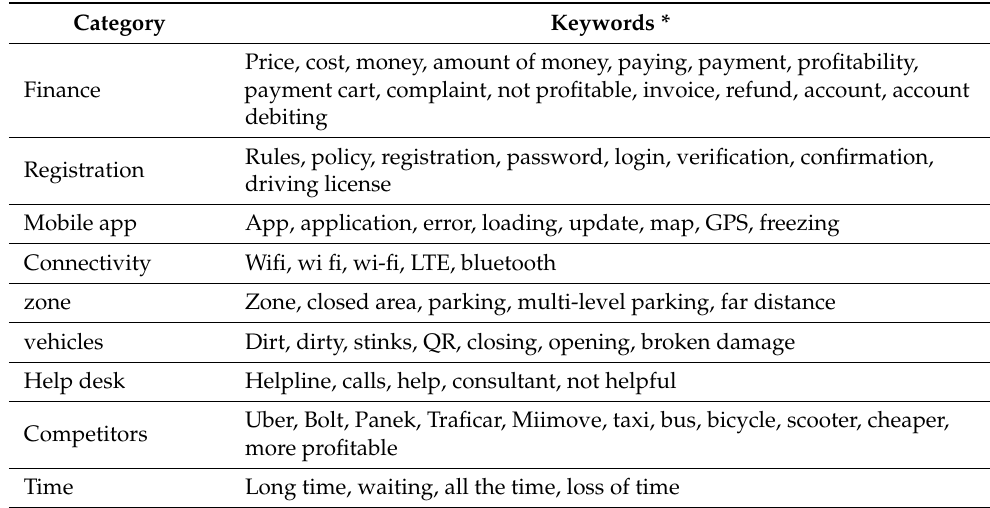
Table A2. Keywords used to identify the problems of